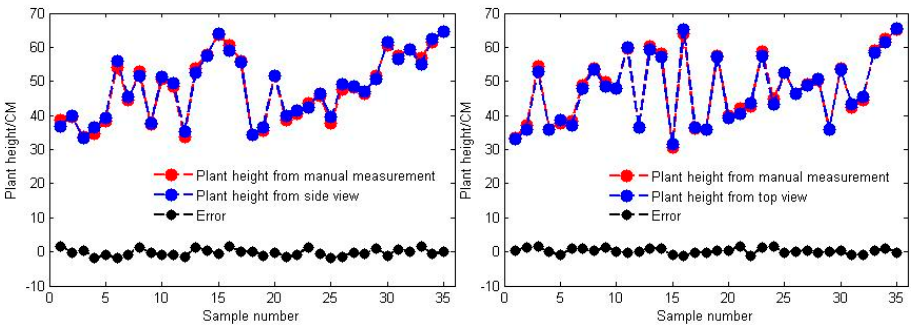
Figure 10. Plant height correlations between 3D measurements and manual measurements. ( left ) Side view ‐ based correlation; ( right ) top view ‐ based correlation.